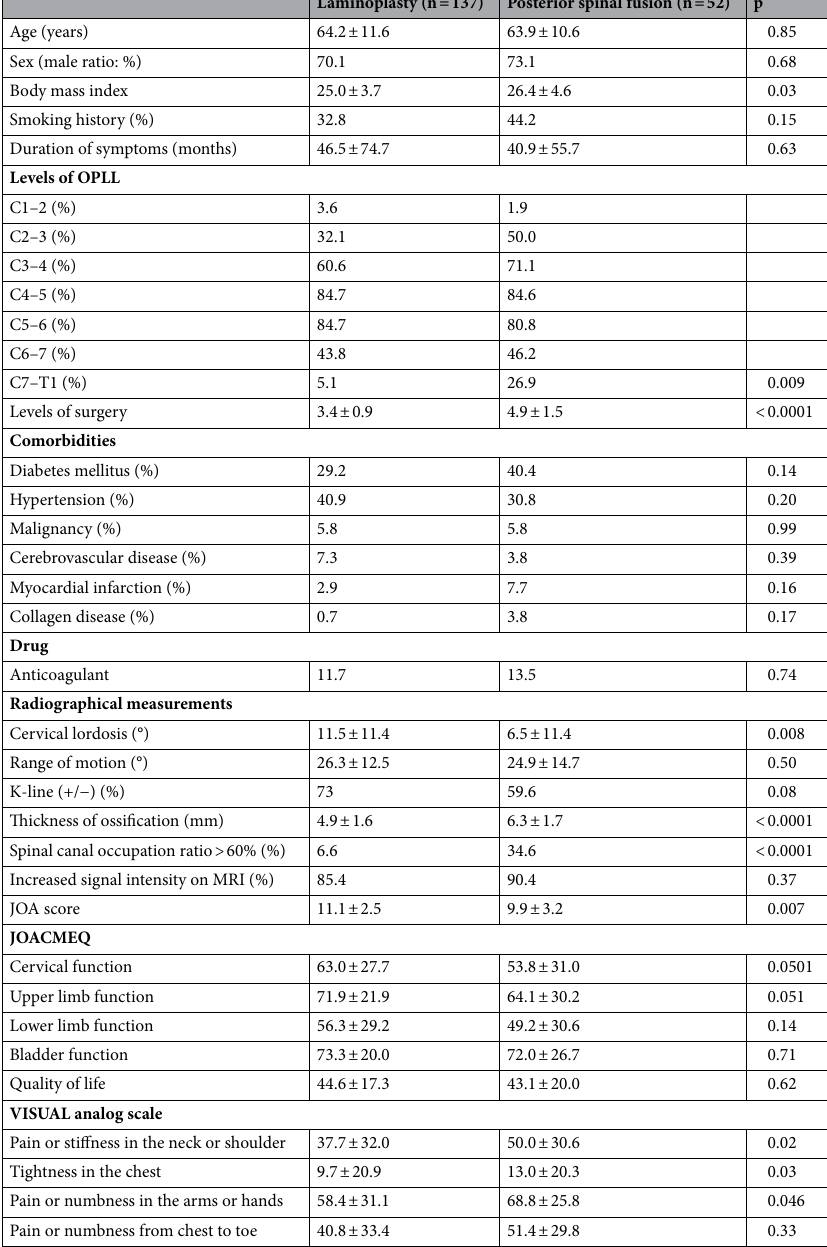
Table 1. Demographic parameters, preoperative radiographical parameters and quality of life in the original sample (before weighting) of patients undergoing laminoplasty or posterior spinal fusion. Summary statistics for continuous variables are means and standard deviations. OPLL ossification of posterior longitudinal ligament, JOA Japanese Orthopaedic Association, JOACMEQ Japanese Orthopaedic Association Cervical Myelopathy Evaluation Questionnaire, MRI magnetic resonance